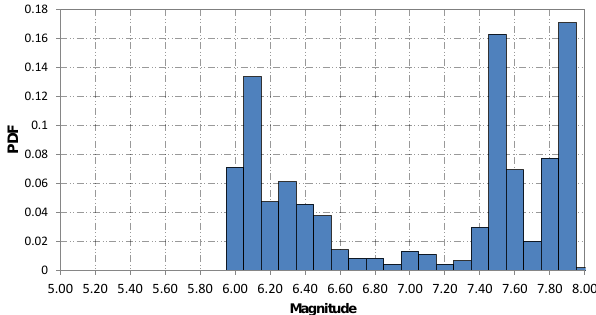
Fig. 4. Probability distribution function (PDF) of earthquake mag- nitudes on the northern San Andreas Fault during the 100000yr VC simulation. Bins are 0.1 magnitude